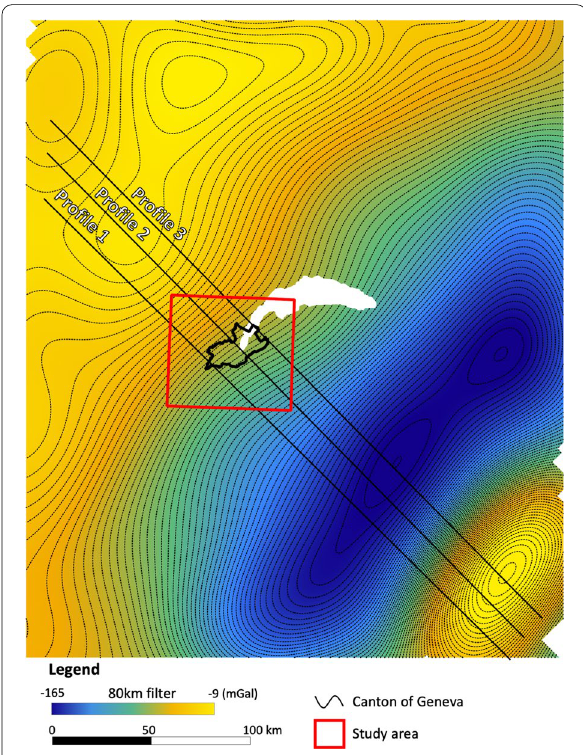
Fig. 7 CBA computed over a region extending at least 50 km from the study area